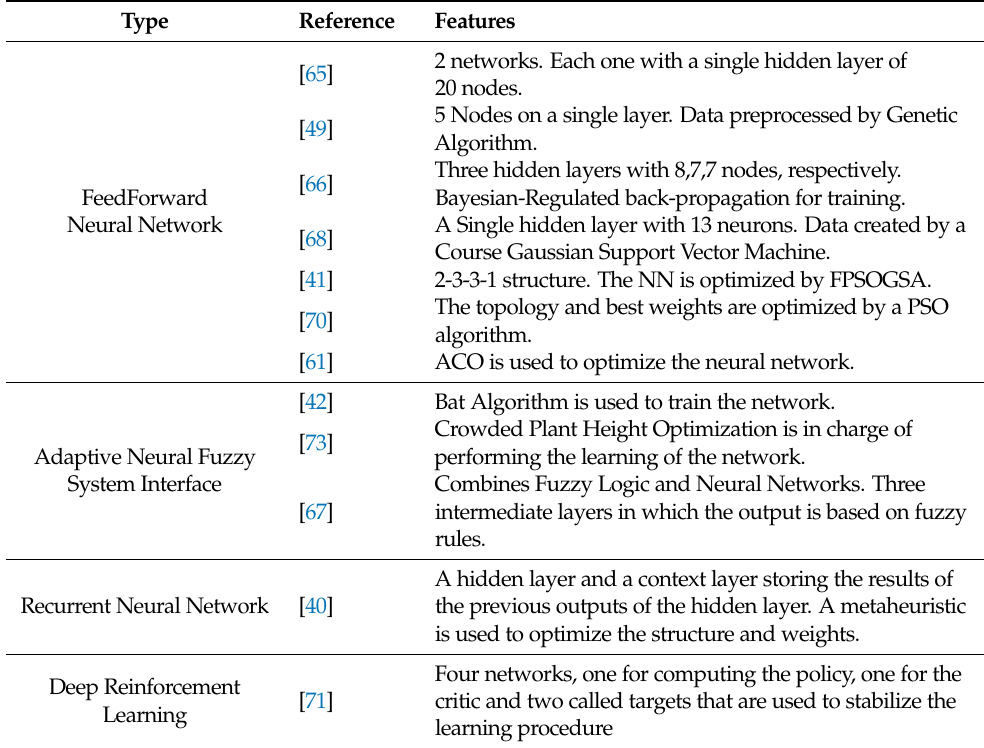
Table 4. Neural Network Models for